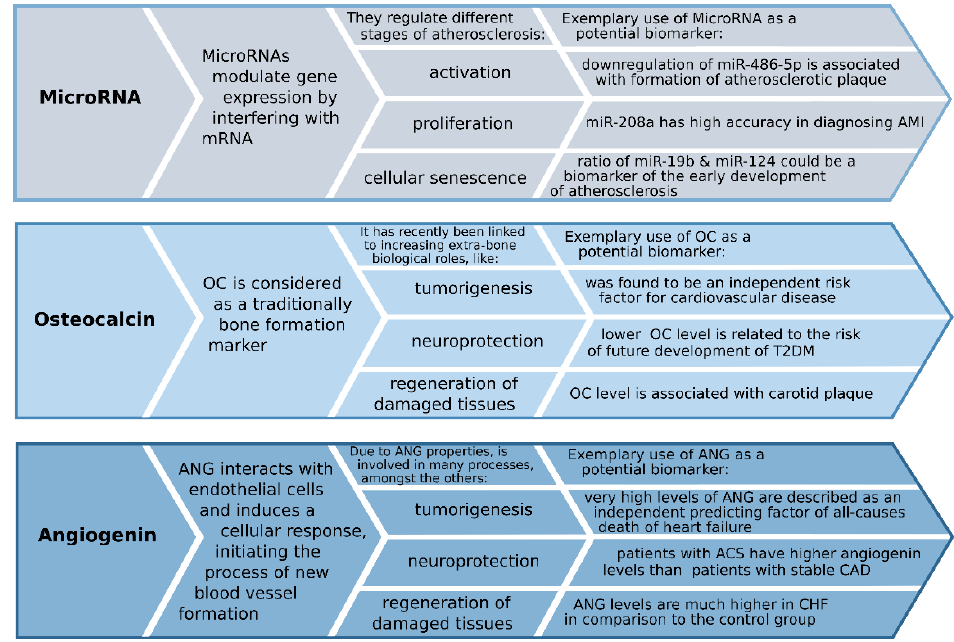
Figure 1. Schematic diagram of potentially new biomarkers mechanism.